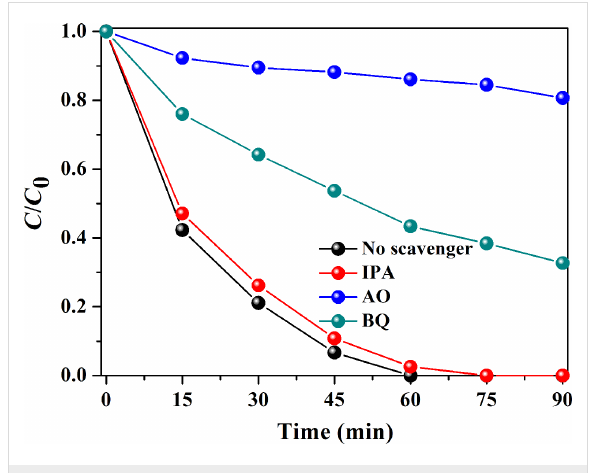
Figure 9: Radical-scavenger tests over